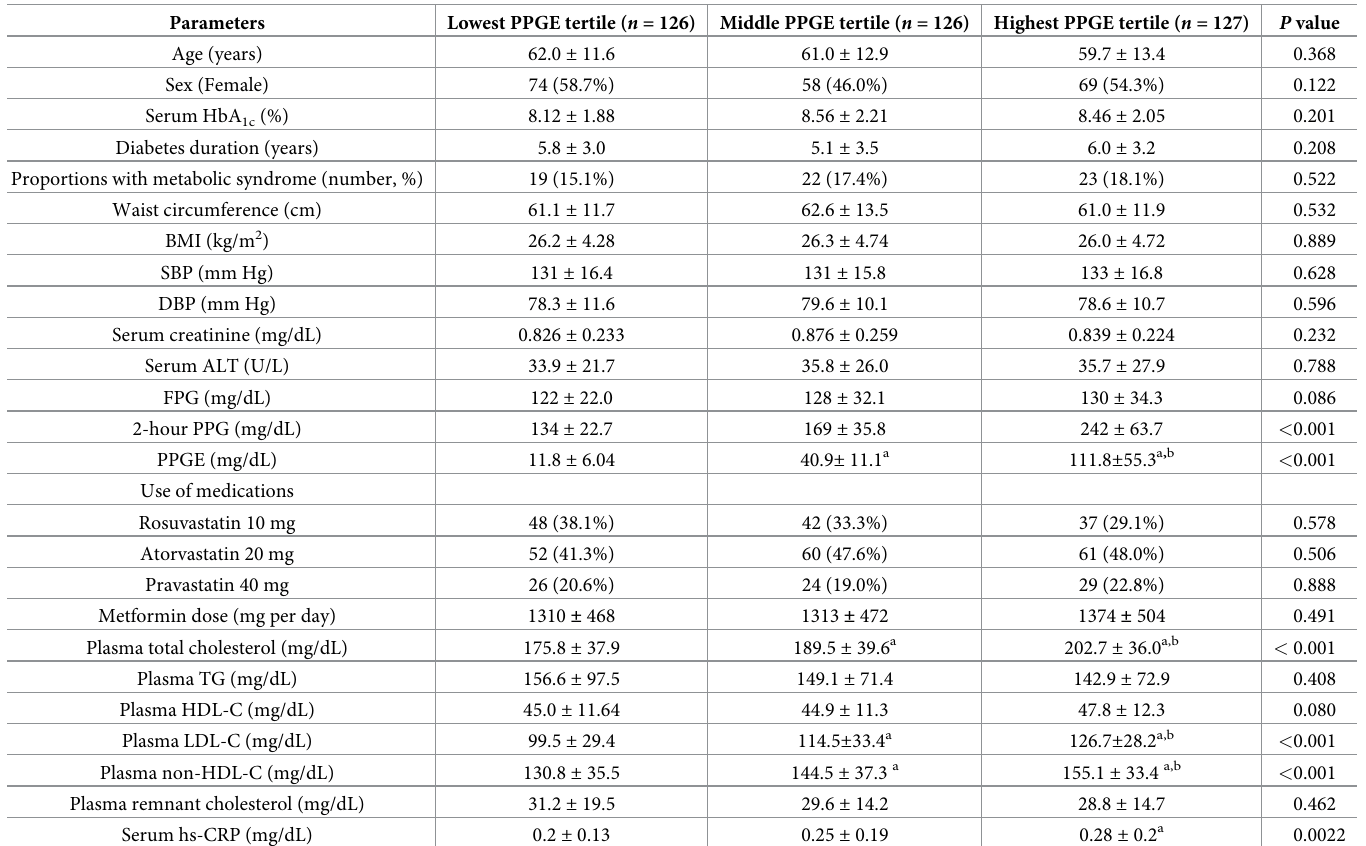
Table 1. Demographic features of the participants.